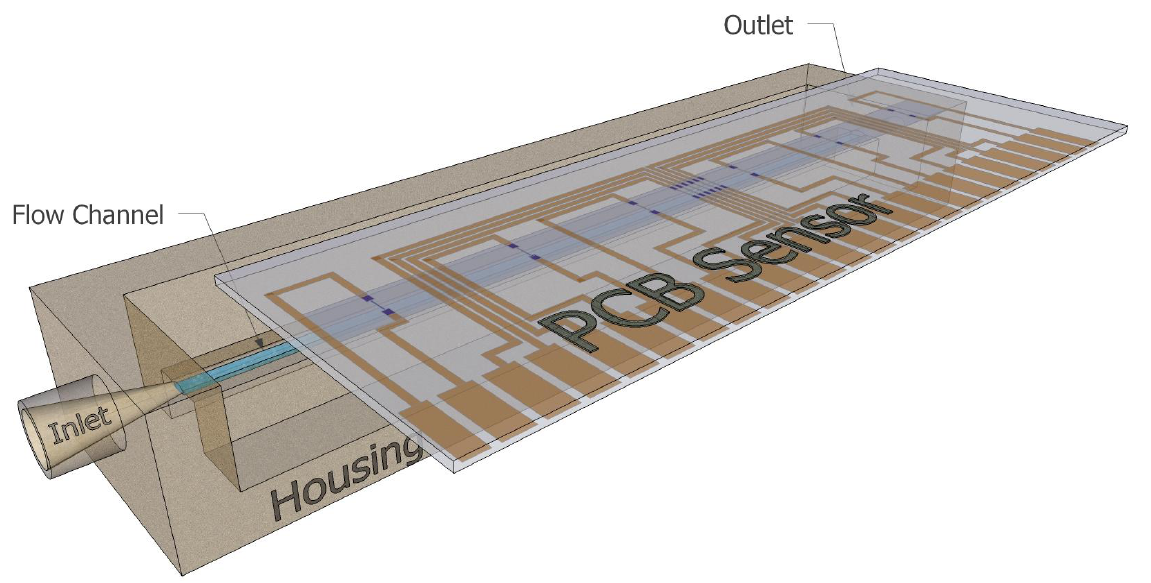
Figure 2. A schematic of the implemented housing. The sensor is adjusted on a special packaging with the resistors’ side facing the defined flow channel. Sealing is assured by a specific O-ring scheme (not shown in the picture).